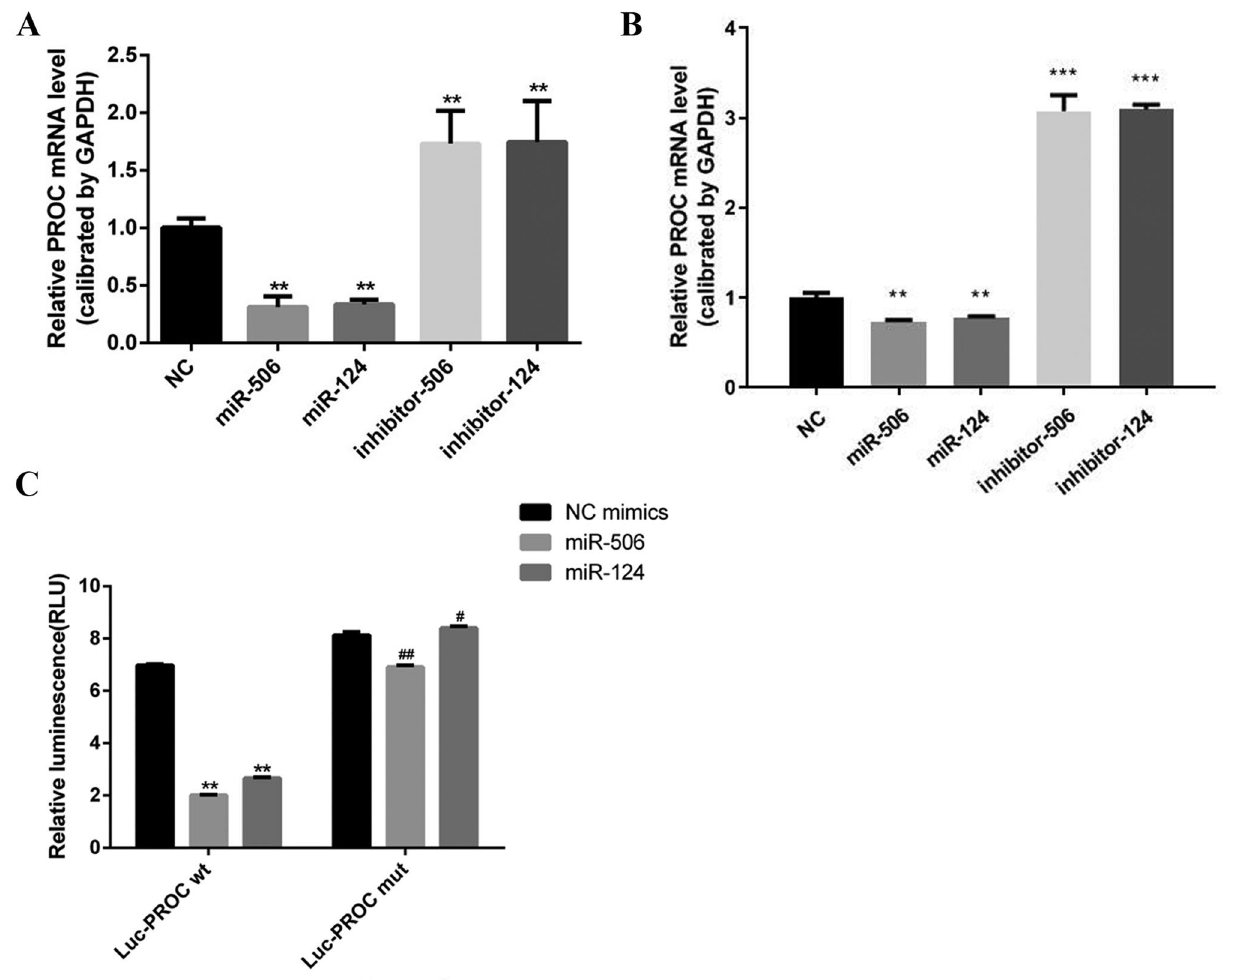
Figure 2. The association of miR-506/124 and PROC. Detection of PROC mRNA in HL-7702 cells ( A ) and LX-2 cells ( B ) transfected with miR-506 or miR-124 mimics, inhibitor and their negative control miRNA. ( C ) HL-7702 cells were co-transfected with miR-506/miR-124 mimics and Luc-wild-type or mutant 3 ′ -UTR of PROC plasmids. Then transcriptional activity of PROC was determined by luciferase assay. ** and ## Represent P < 0.01; ***represents P < 0.001; # represents P <